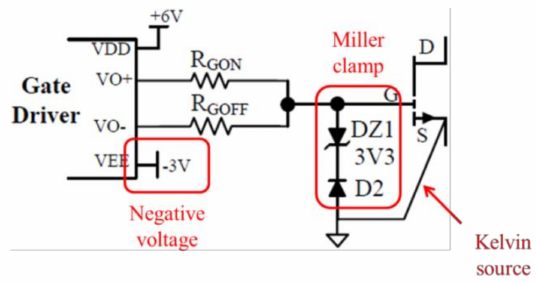
Figure 10. Driving loop with active Miller clamp, Kelvin source connection, and negative turn-off voltage